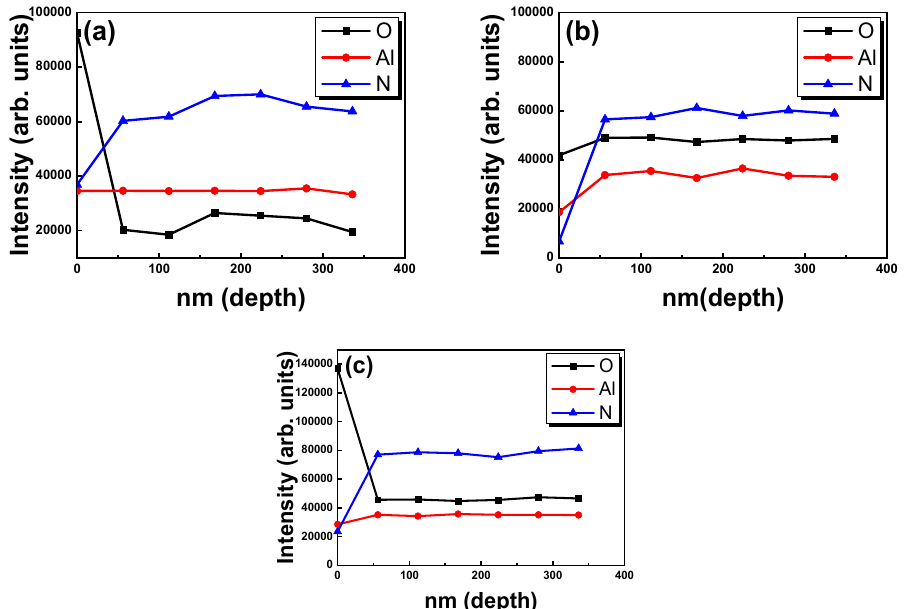
Figure 5. Depth profile analysis for AlN thin film samples with N 2 flow rates of ( a ) 20, ( b ) 30, and ( c ) 40 sccm.